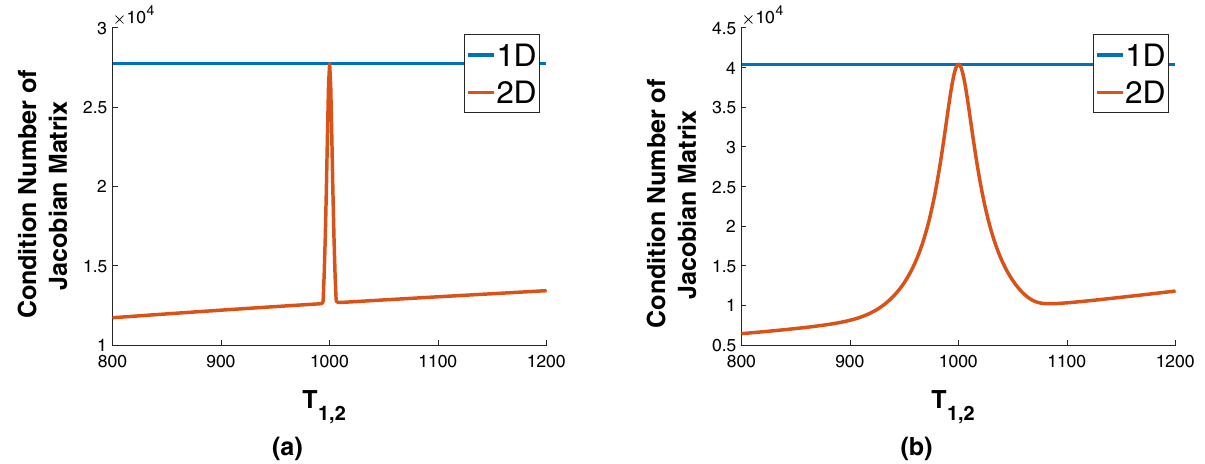
(a) Figure 6. Condition number of the Jacobian matrices for 1D and 2D models. Left: c c T T ( 0.3, 0.7, 60 ms, 45 ms ) , with T 1,1 Results for p ∗ 1 , 2 , 2,1 , 2,2 = = 2D case and calculations performed across a range of T 1,2 . Right: Analogous results for (cid:31) (cid:30) c c T T ( 0.8, 0.2, 90 ms, 160 ms ) . As seen, the condition number for the 2D case in which p ∗ 1 , 2 , 2,1 , 2,2 = = T T (cid:31) (cid:30) 1,1 1,2 is close to that of the 1D =